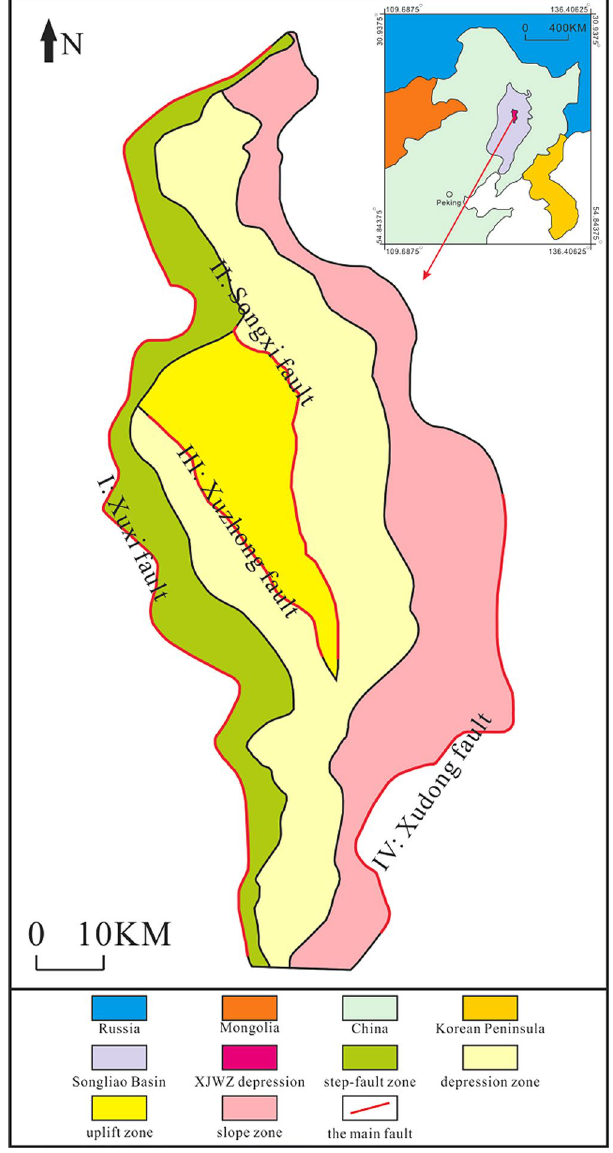
Figure 1. A tectonic map showing the major fault systems related to the XJWZ depression (adapted from Figs 2–14 presented by Ren 19 ). The Xuxi fault, which is on the west boundary of the XJWZ depression, is responsible for the fault-related anticline. The data are from http://www.265.me/, and the figures were produced using the CorelDRAW software (Version X8) (http://www.corel.com/cn/). The inset shows the geographical location of XJWZ, which is adapted from Figure 2–3 presented by Zhang 1 .